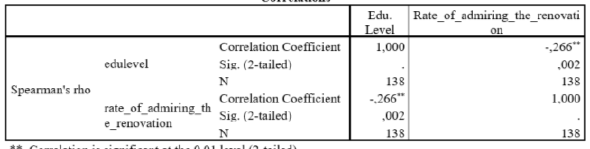
Table 1. Spearman’s Correlation between the educational level and the rate of admiring the final interventions among the